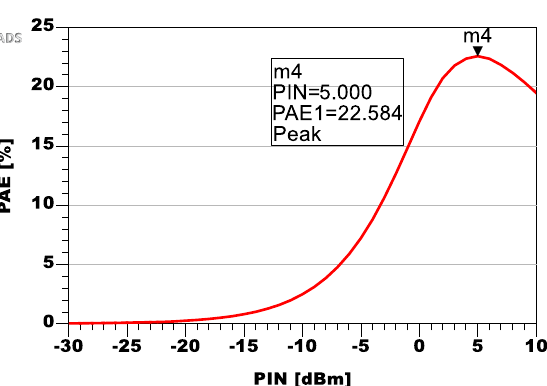
Fig. 20. Power Added Efficiency @ 2.4